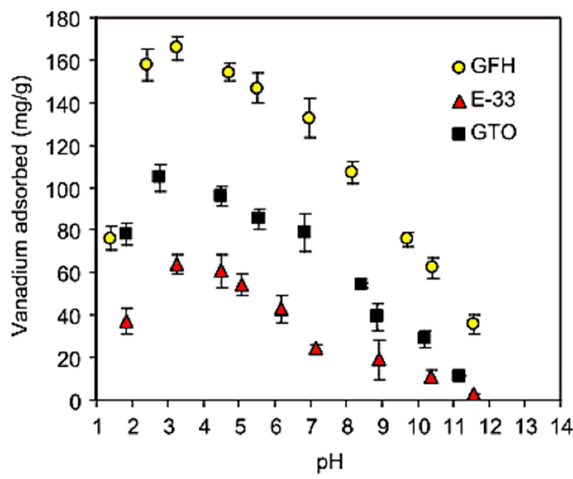
Figure 5. Vanadium adsorption isotherms obtained for 0.35 g/L dry mass of GFH and E-33, and 0.50 g/L of GTO (25 °C, ionic strength 0.01 M NaClO 4 , initial vanadium concentration 50 mg/L), taken from [68].